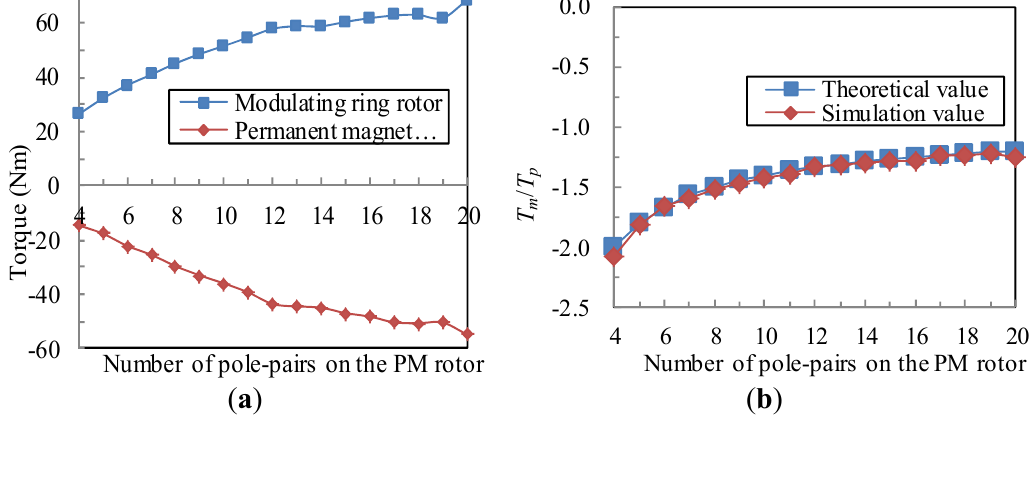
Figure 10. Torque transmission characteristics: ( a ) variation of torque with the number of pole pairs of the permanent magnet (PM) rotor; and ( b ) Variation of torque ratio with the number of pole pairs of the PM